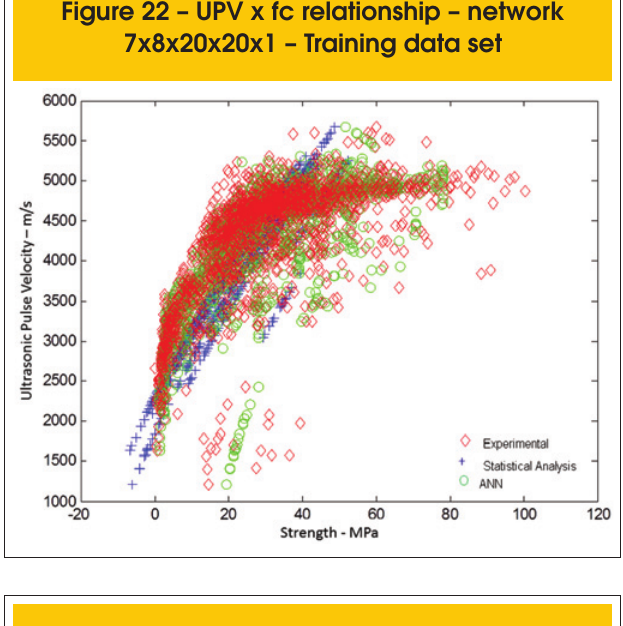
Figure 23 – UPV x fc relationship – network 7x8x20x20x1 – Test data